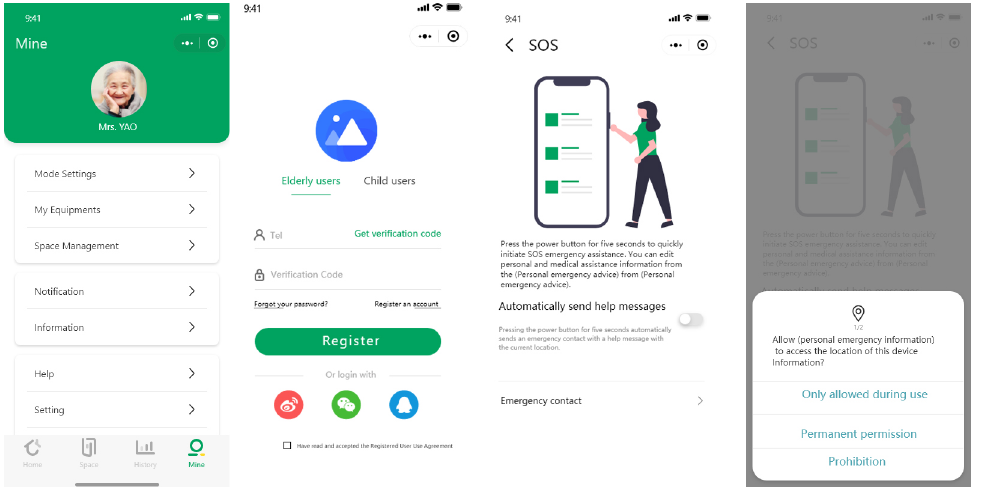
Figure 1. Elderly smart phone use. Designed in-house by the team, the overall colour palette was chosen in accordance with the principles of appropriate ageing design.